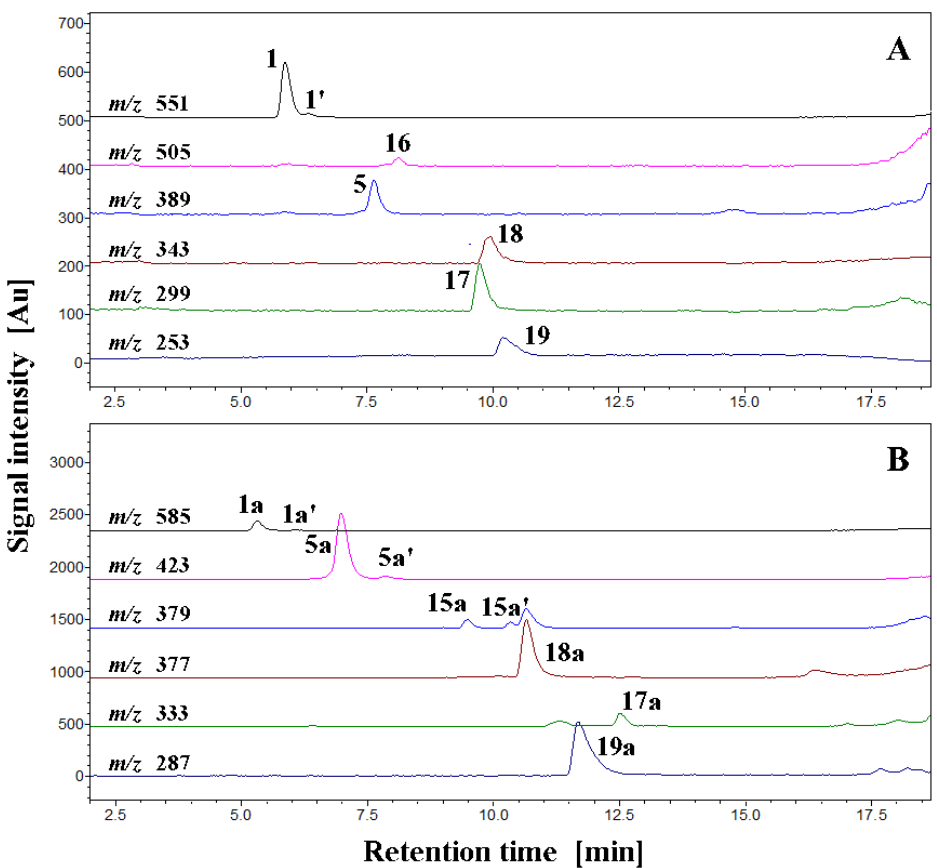
Figure 4. Chromatograms of NaOCl-induced (pH 7.4) betanin chlorination as well as oxidation, deglucosylation, and decarboxylation products registered in selected ion monitoring mode. The ions of non-chlorinated pigments ( A ) and chlorinated derivatives ( B ) are